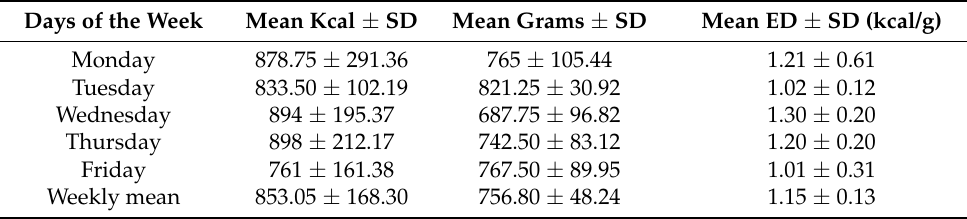
Table 3. Mean energy value (kcal), meal plate weight (grams), and energy density (ED—kcal/grams) of the monthly menus from the community restaurants,